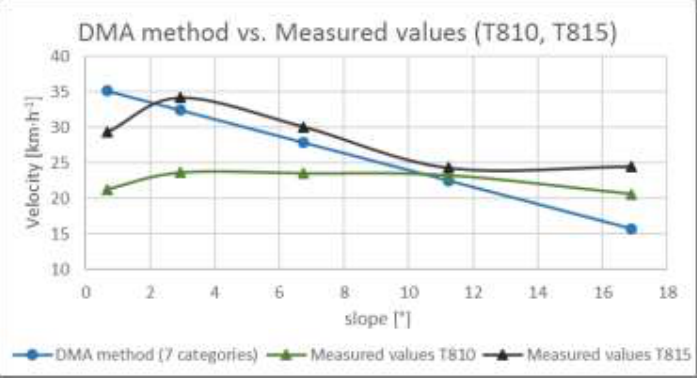
Fig. 4: The comparison of the calculated and measured values (T810,